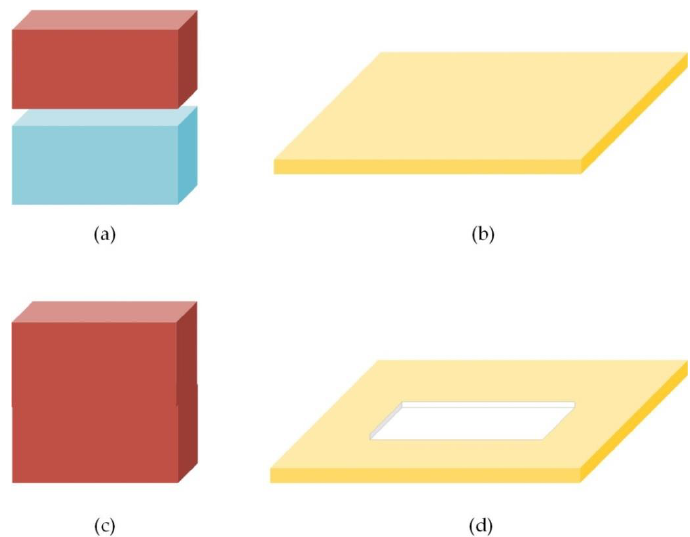
Figure 14. Comparison of single-floor and cross-floor space extraction: ( a ) single-floor space 3D model, ( b ) floor slab without a hole, ( c ) cross-floor space 3D model, and ( d ) floor slab with a hole.